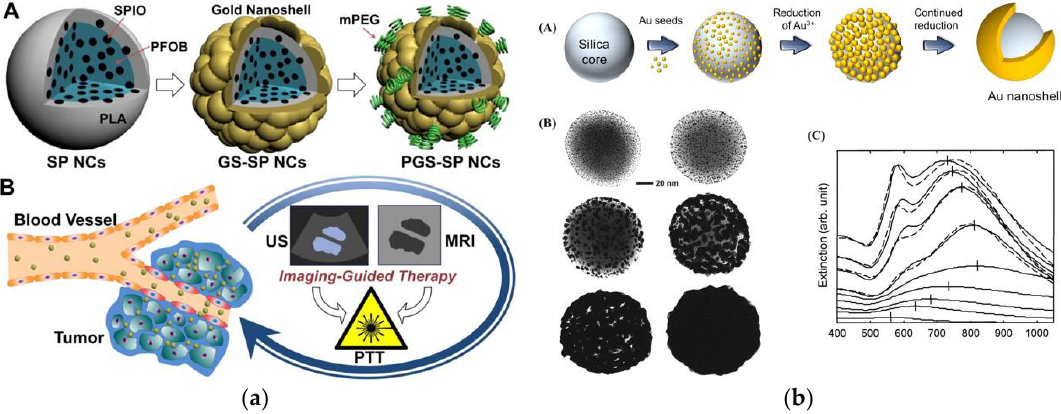
Figure 12. ( a ) Silica core–gold shell nanoshells [Reproduced from [122], with permission